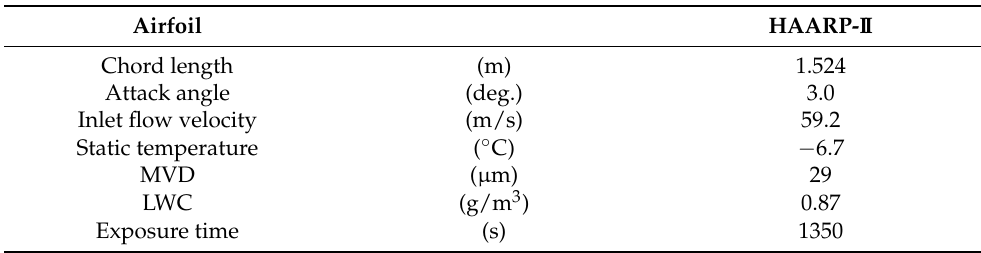
Table 1. Numerical conditions in the icing simulation for the HAARP-II airfoil. The condition follows the experiments by Papadaikis et al.